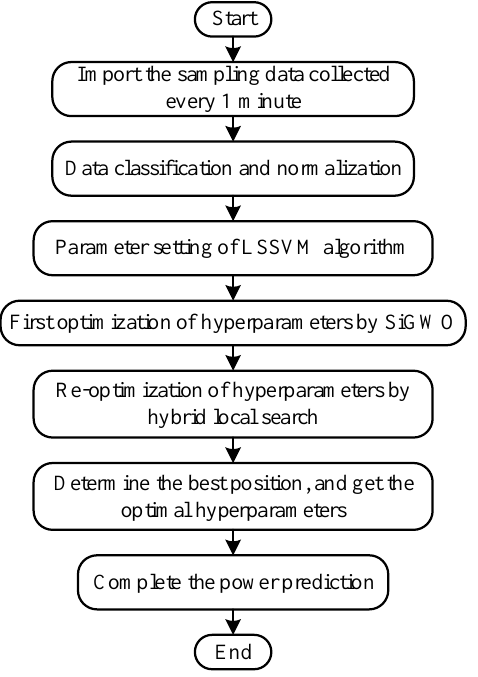
Figure 4. Main flow chart of the proposed